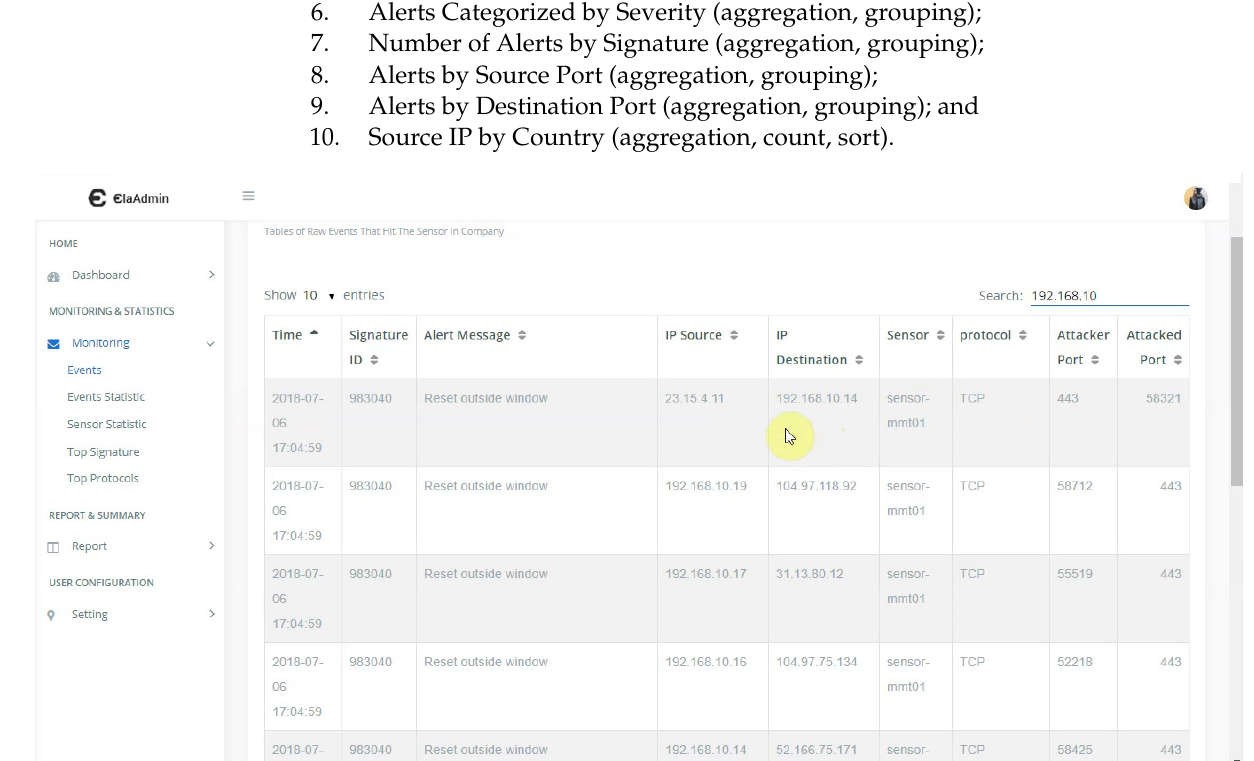
Figure 9. The dashboard shows the network security event data. The left menu contains two sub ‐ menus: (1) Monitoring & Statistics and (2) Report & Summary.